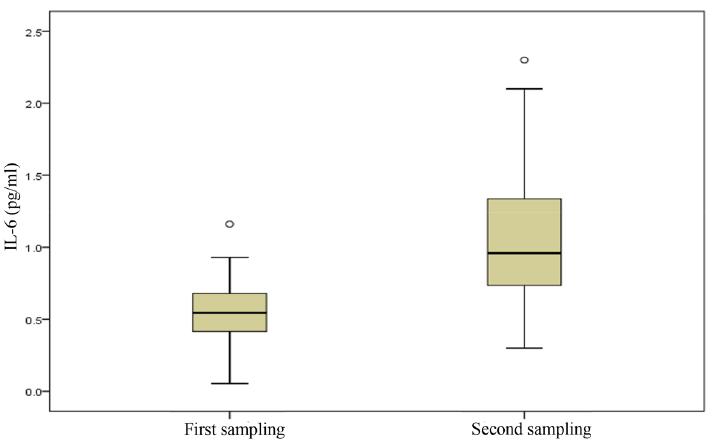
Figure 2. The concentration of IL-6 in EBC in two sampling periods.